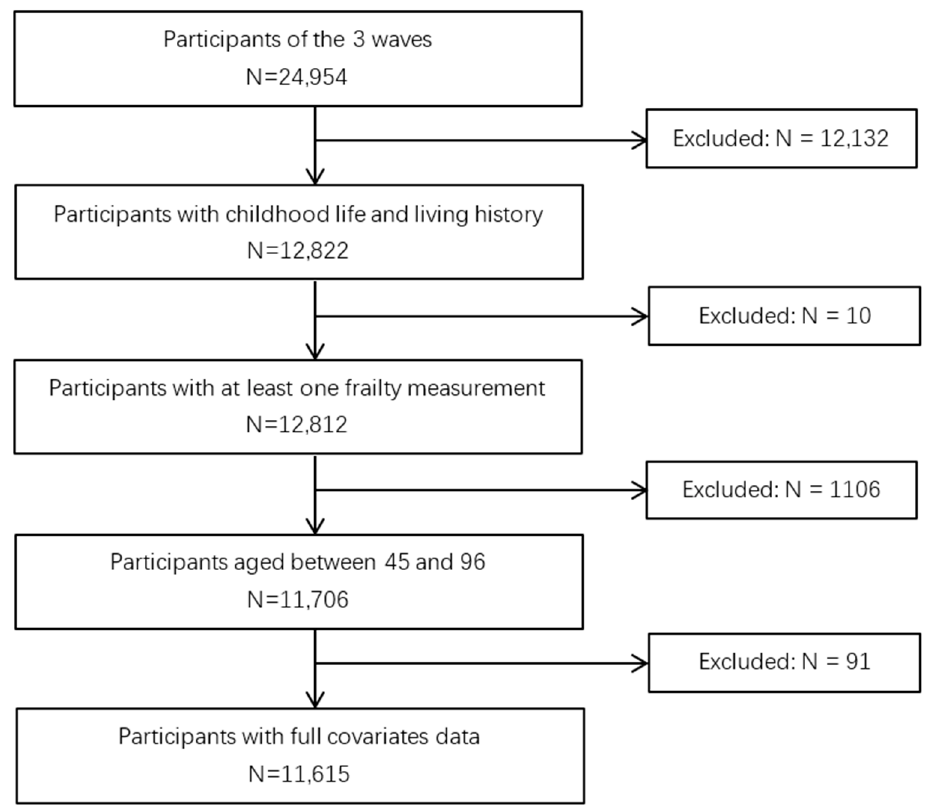
Figure 1. Flowchart on the sample selection and exclusion.